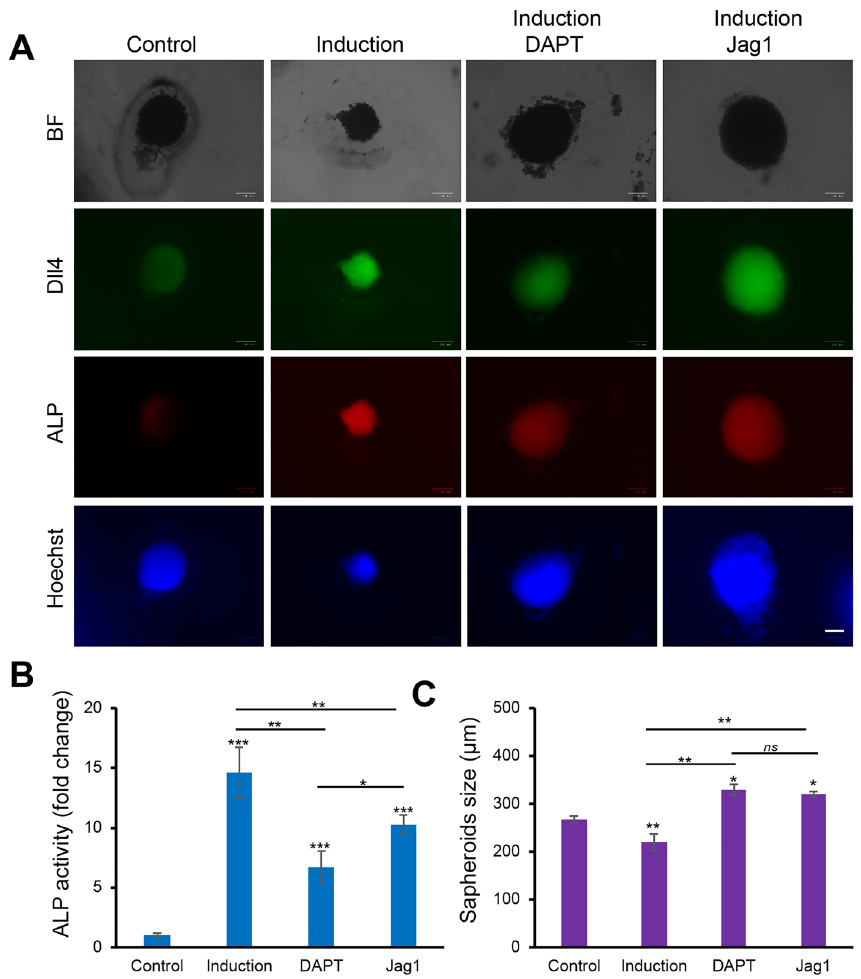
Figure 6. Notch1-Dll4 signaling regulates 3D hMSCs spheroids osteogenic differentiation. ( A ) Representative bright field and fluorescence images of hMSCs spheroids in control, induction, DAPT and Jag1 treatment groups. Green: Dll4 mRNA expression; red: ALP activity; blue: nucleus. Scale bar: 100 μm. ( B ) Quantification of ALP activity of hMSCs spheroids under different treatments. ( C ) Characterization of spheroids sizes under different treatments. Data represent over 50 spheroids in each group and are expressed as mean ± s.e.m. (n = 4, *** p < 0.001, ** p <